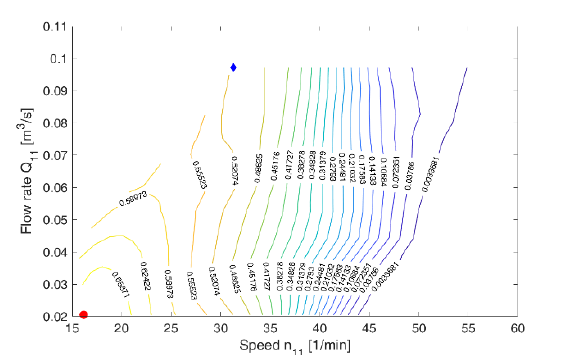
Fig. 14. Q 11 n 11 diagram for configuration, bucket 00 and channel edge position -40 for different flow rates.